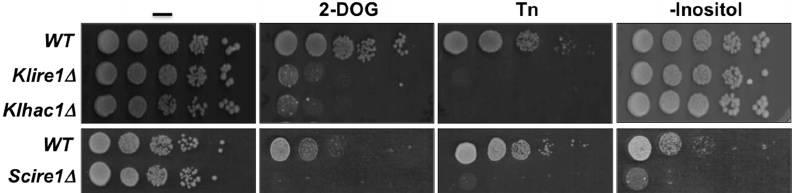
Figure 4. Effect of IRE1 and HAC1 inactivation on the K. lactis growth properties. K. lactis null mutants were obtained by standard homologous recombination introducing in both cases the URA3 selective cassette. K. lactis cells were grown in YPD (1% yeast extract, 2% peptone, and 2% Glucose) until 0.5 OD 600 then were washed and suspended in fresh YPD. Cells were spotted as 10 fold serial dilutions on YPD plates containing 15 mM 2-DOG or 50 ng/mL Tn and on plates of 2% glucose, 0.5% ammonium sulfate, 0.17% yeast nitrogen base w/o amino acids and w/o inositol. S. cerevisiae wild type and ire1 ∆ strains were included as controls. Cells were plated on the same media except that the 2-DOG concentration was 20 mM and the Tn concentration was 500 ng/mL. Plates were incubated at 30 ◦ C and photographed 48 h later.